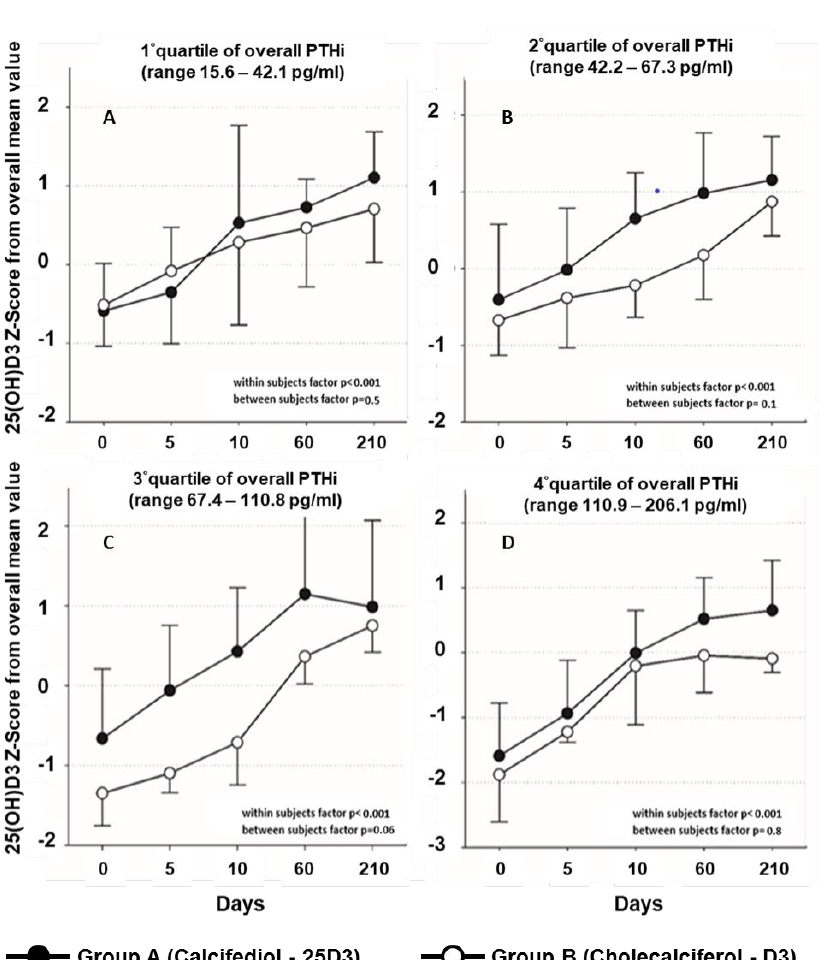
Figure 2. Mean values of serum levels of 25(OH)D, (expressed as a number of SD from the overall mean value), over time among participants grouped according to the type of intervention and stratified by quartiles of overall basal iPTH levels. Panel A shows the mean values of serum